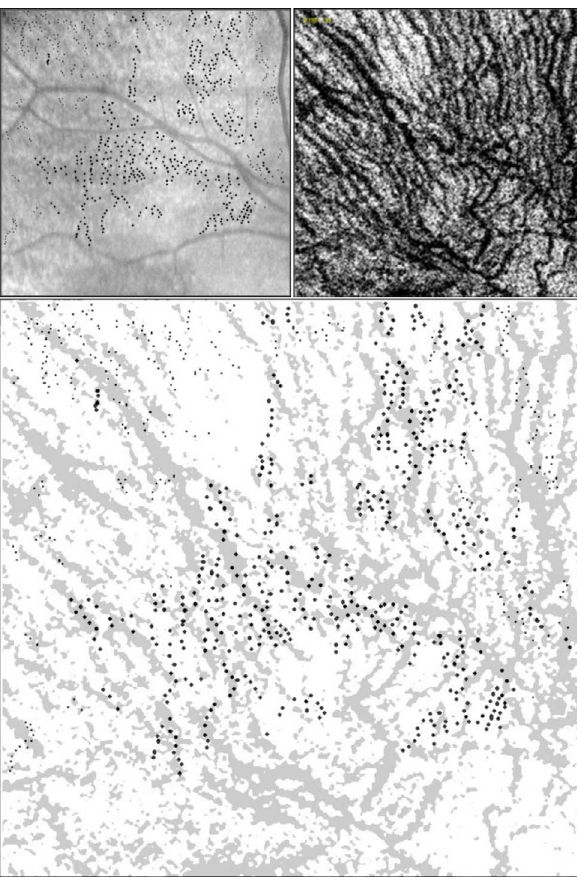
Figure 7. RPD lesions correlate with choroidal vasculature. IR reflectance RPD lesions shown as black dots (top left) and en face OCT C-scan (top right). Overlay of the RPD lesions and the thresholded C- scan highlighting the choroidal vasculature show an association between the location of the RPD lesions and the choroidal blood vessels (bottom). Of the 751 RPD lesions in this image, 31% were over the choroidal vasculature (n=233). Of the lesions over the stroma (n=518), 57.34% were between 1–3 pixels, 28.76% between 4–6 pixels, and 13.9% were $ 7 pixels away from the choroidal vasculature.